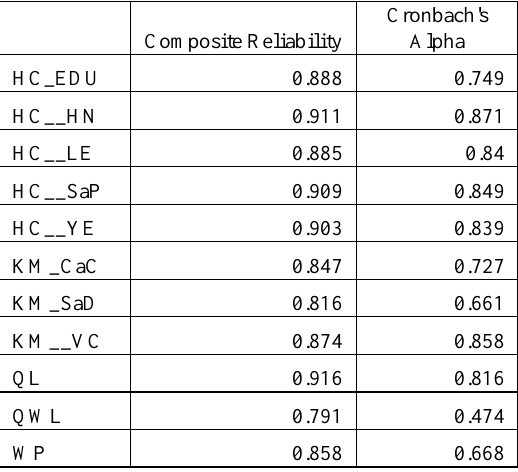
Table 2: VIF for Multi-Collinearity Table 3: Composite Reliability and Cronbach's Alpha